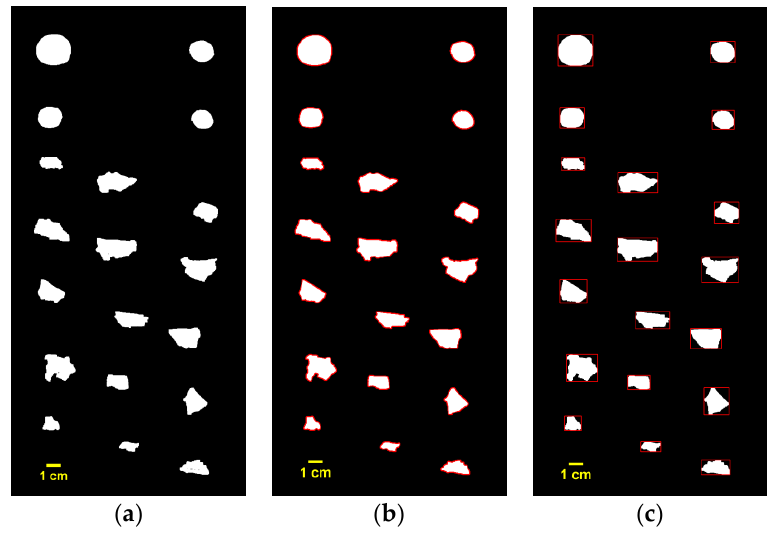
Figure 5. Image processing: ( a ) binary image; ( b ) image with border lines; and, ( c ) scraps with minimum rectangle bounding box.